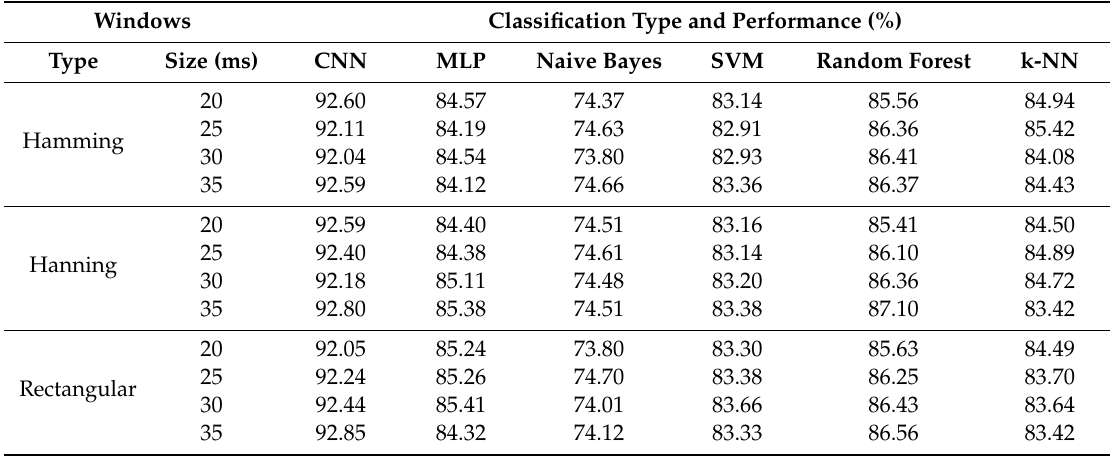
Table 4. Performance accuracy for male speakers based on GRU + EZMFCC.